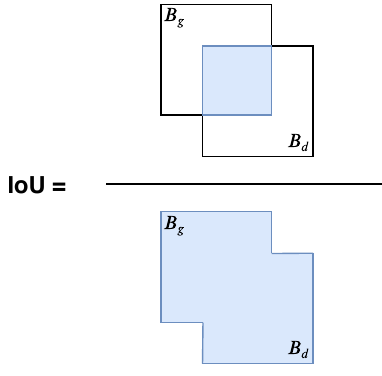
Figure 9. Interception over union